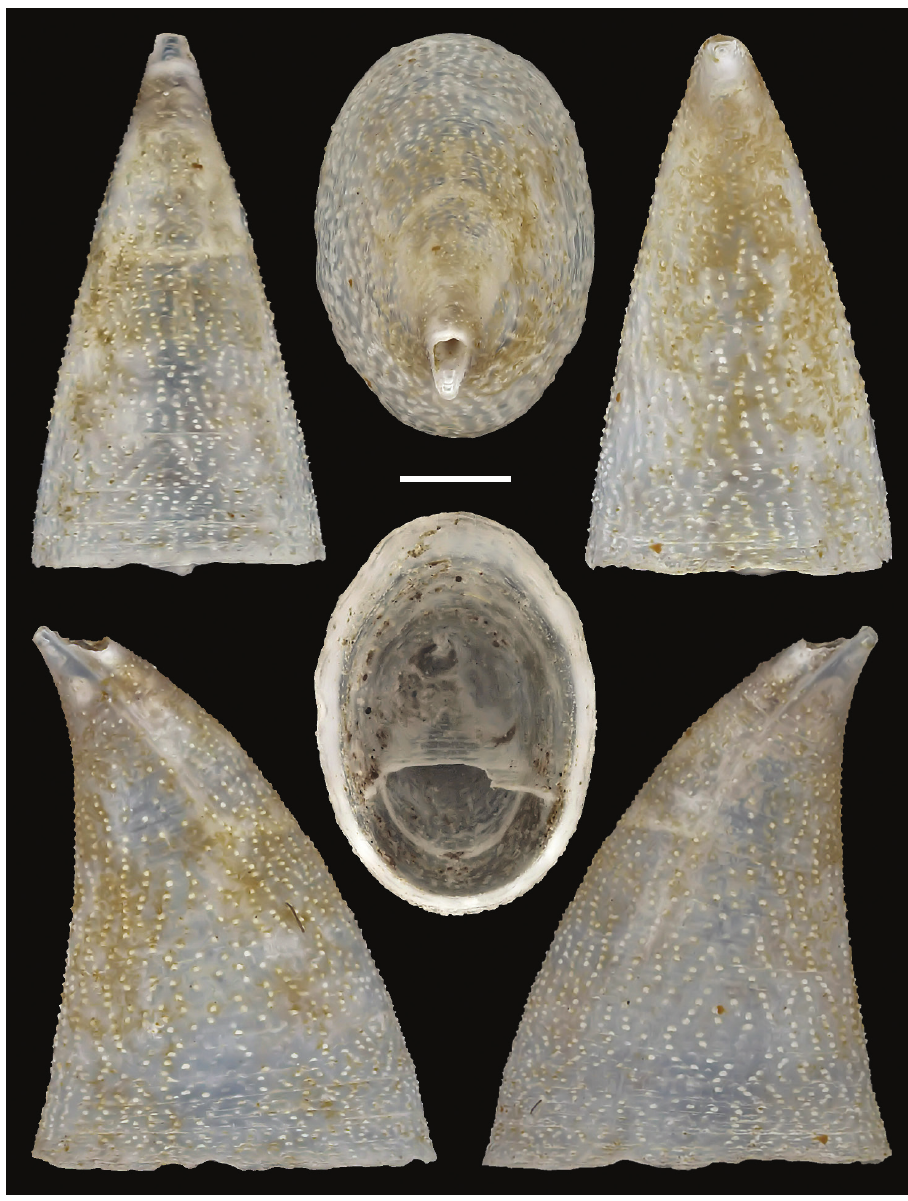
Figure 12. Fissurisepta onychoides Herbert & Kilburn, 1986. Holotype T3017/NMSA-MOL 0C6365. Scale bar: 1